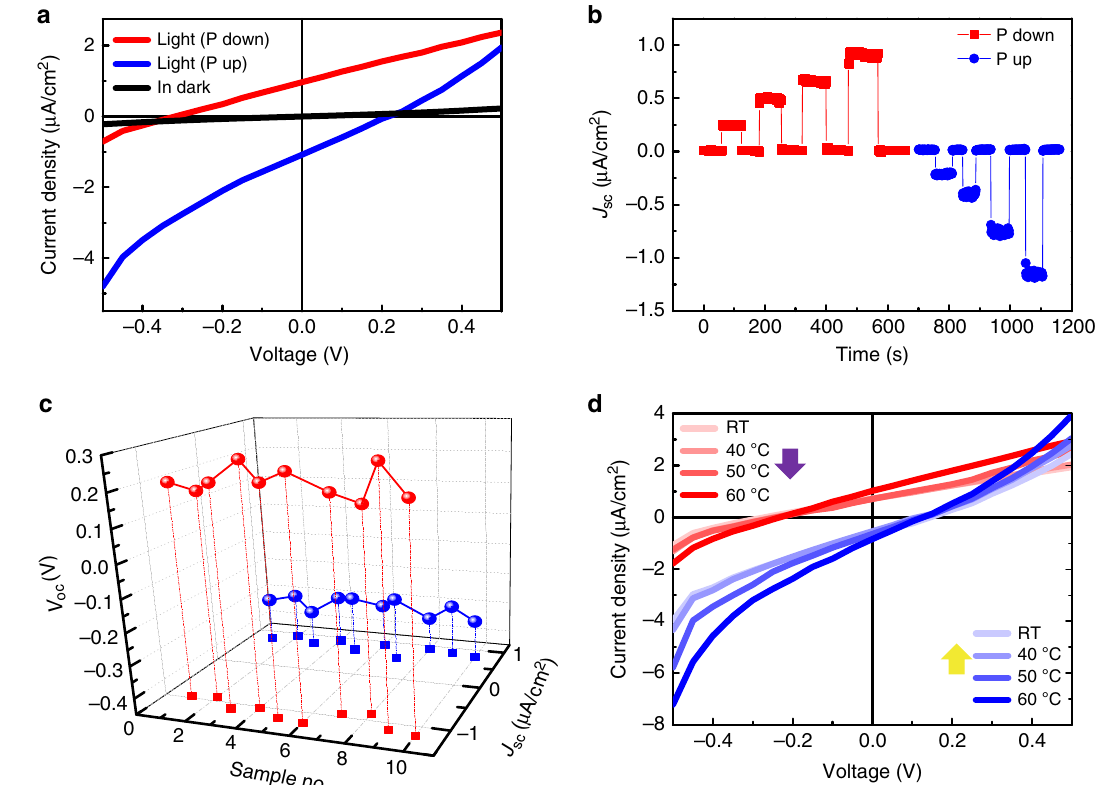
Fig. 3 Photovoltaic properties of freestanding Pt/BFO/LSMO devices. a J – V curves of the transferred freestanding Pt/BFO/LSMO photovoltaic cells under light illumination and in dark. Light source: halogen lamp with energy density of 20 mW/cm 2 . b Photo response as function of time under different light intensities or in dark for both polarizations. J sc drops to 0 when turning off the light and increases with the increase of light intensity. c Uniformity of V J fi ve freestanding photovoltaic samples. d Thermal stability of the freestanding photovoltaic devices oc and sc of randomly chosen devices from different with J – V curves measured for both polarizations at different temperatures from room temperature to 60 °C. The purple and yellow arrows represent the downward and upward polarization of